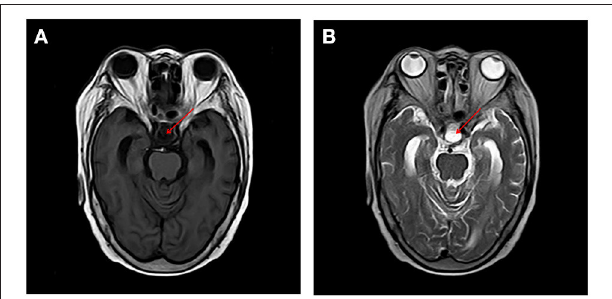
FIGURE 1 | MRI of the brain revealed change after removal of pituitary tumor and no acute cerebral infarction, cerebral hemorrhage, and inflammatory changes were found on T1 and T2 sequences [T1, T1-Weighted Magnetic Resonance Imaging; T2, T2-Weighted Magnetic Resonance Imaging (A) T1, (B)